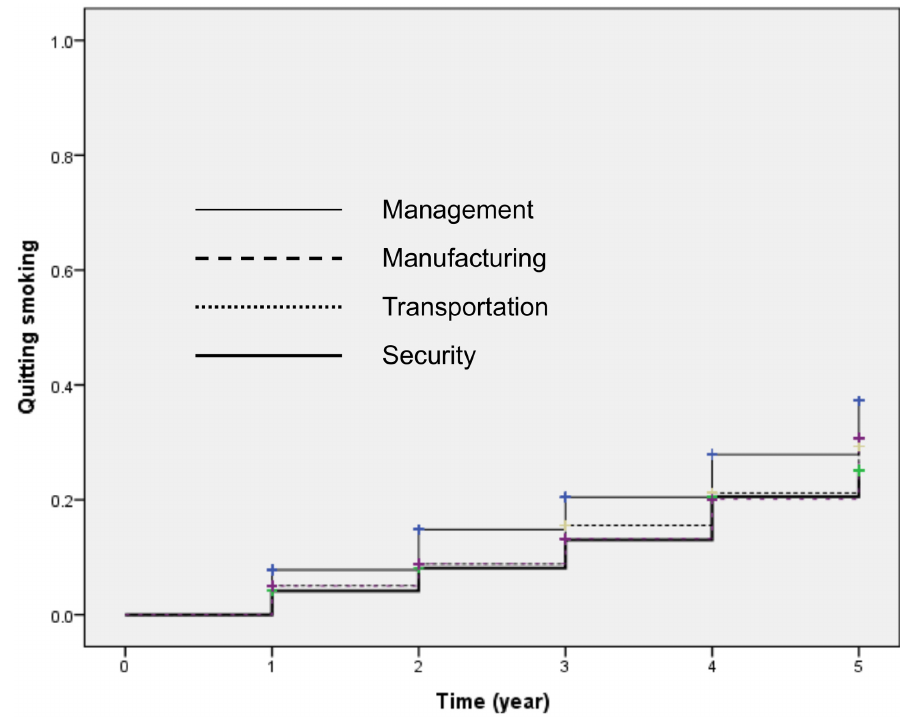
Fig 1. Kaplan-Meier curves for smoking cessation by workers in management, manufacturing, security and transportation (p < 0.01, log-rank test).